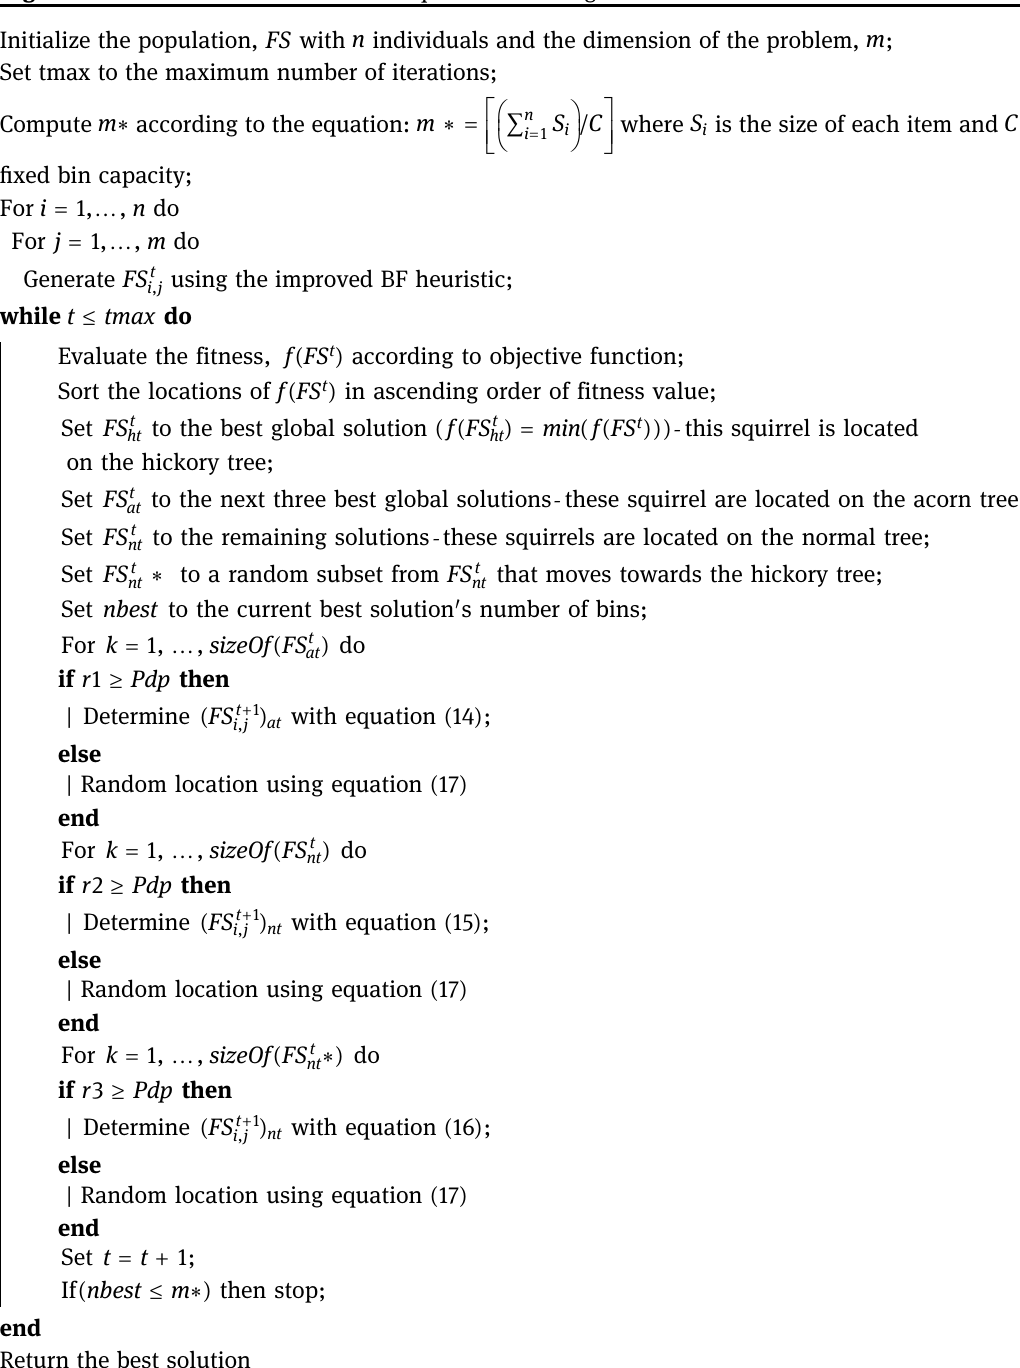
Algorithm 4 : Pseudocode of modi fi ed squirrel search